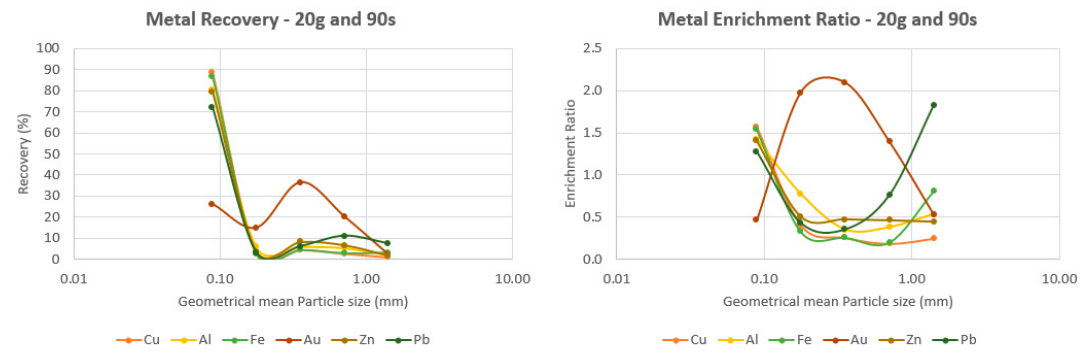
Figure 9. ( a ) Metal recovery and ( b ) metal enrichment ratio after hammer milling as a function of feed mass, milling time and particle size. Feed particle size fraction was 1–2 mm. The feed mass was 20 g and milling time was 90 s. Experimental data points are connected with lines for the purpose of visual aid only.